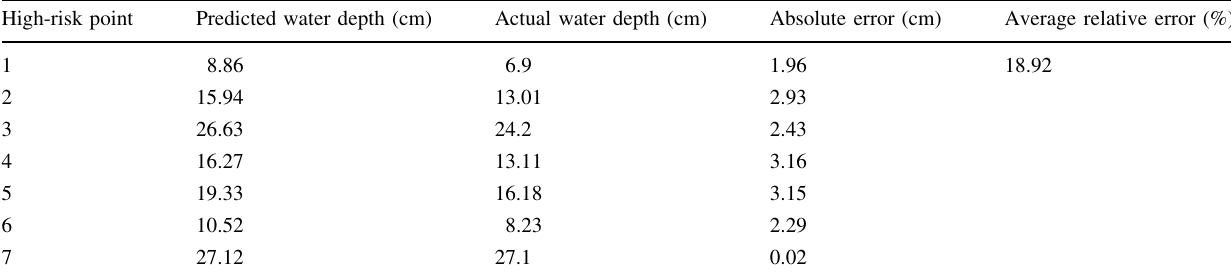
Table 5 Prediction results of stagnant water at the seven high-risk flood points in the study area on Jiefang South Road in Tianjin Municipality, China High-risk point